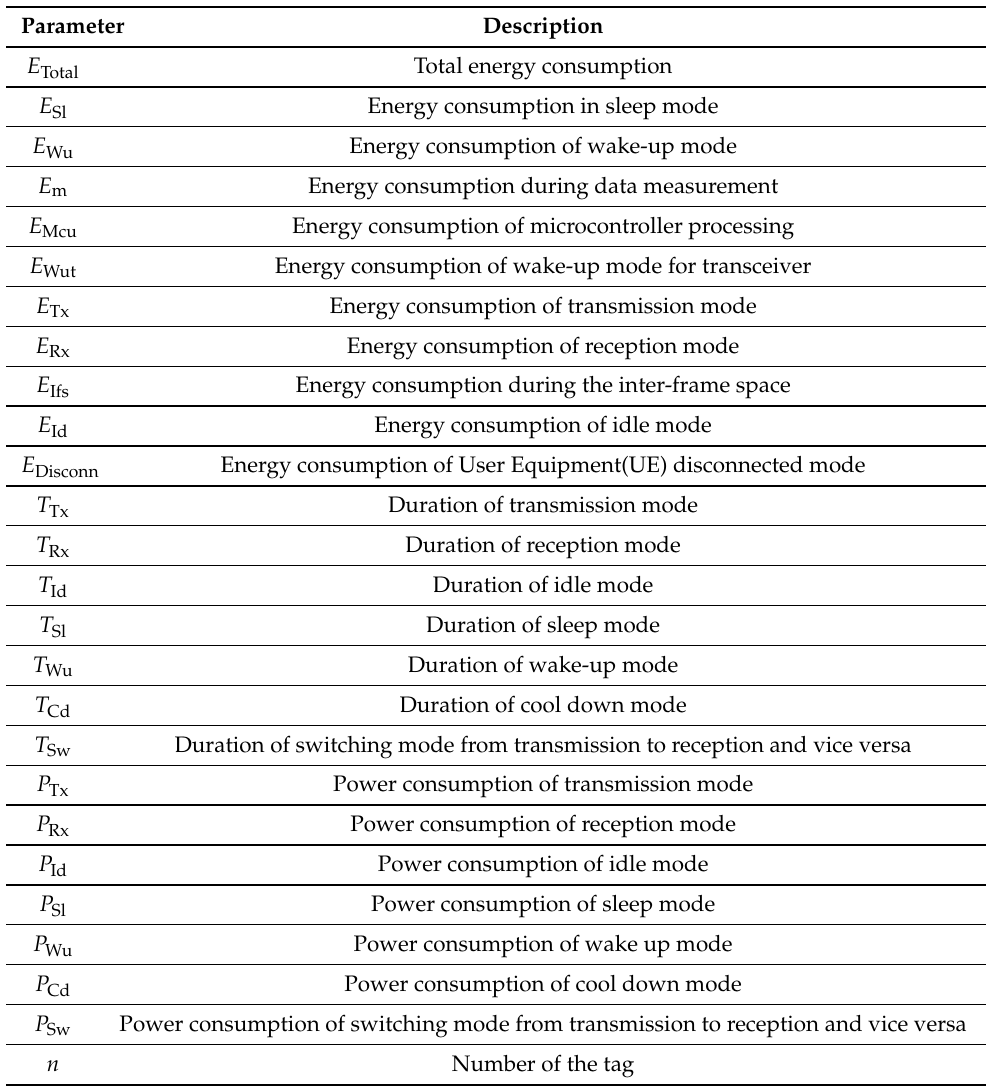
Table 1. Parameters of the energy model